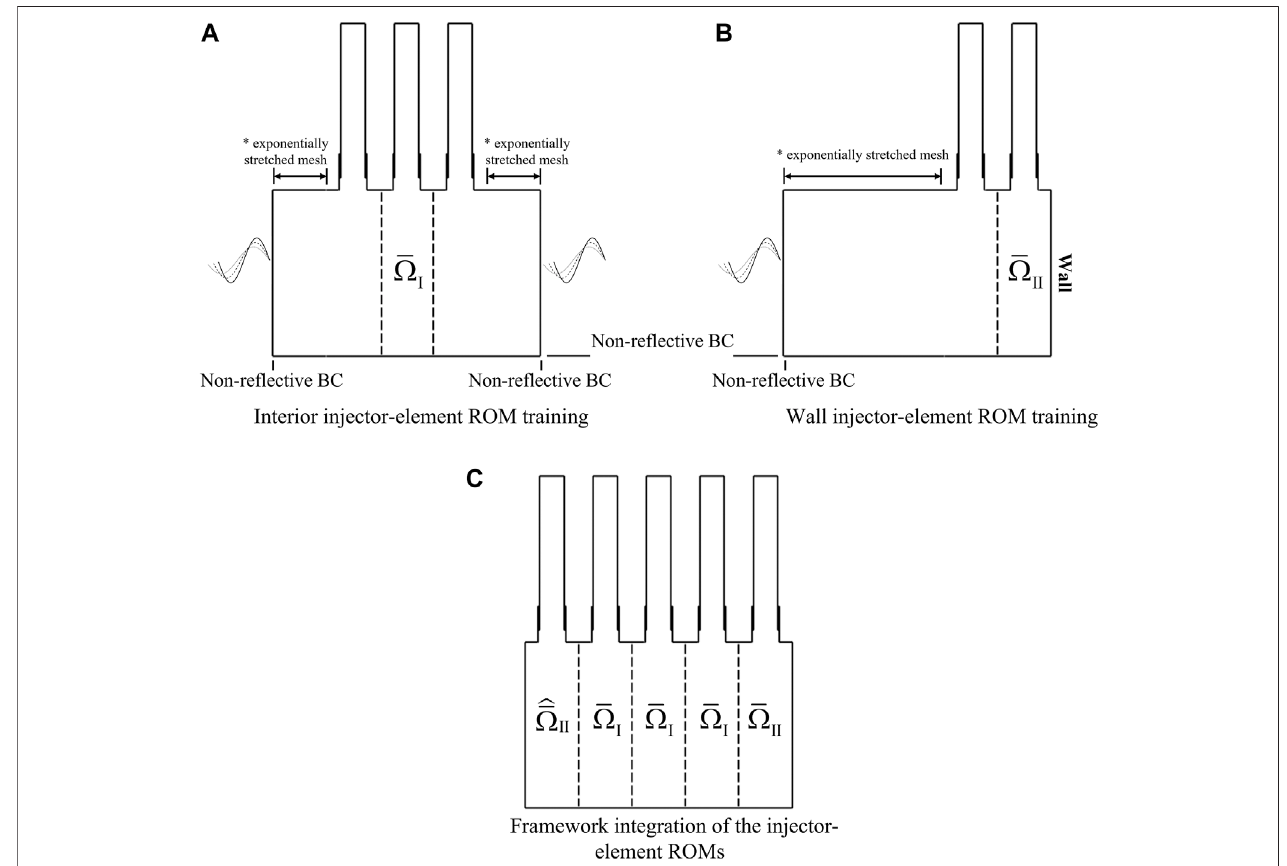
FIGURE 9 | Component-based ROM training strategies for (A) the interior injector element and (B) the wall injector element and (C) the integration of the injector- element ROMs for the 2D-planar multi-injector model rocket combustor.